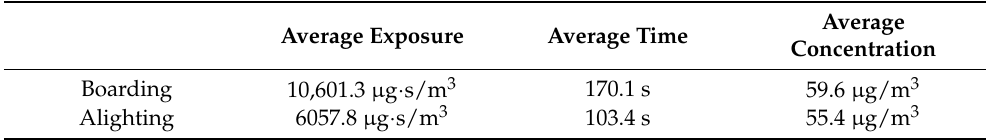
Table 6. PM2.5 Exposure Measurement Results.